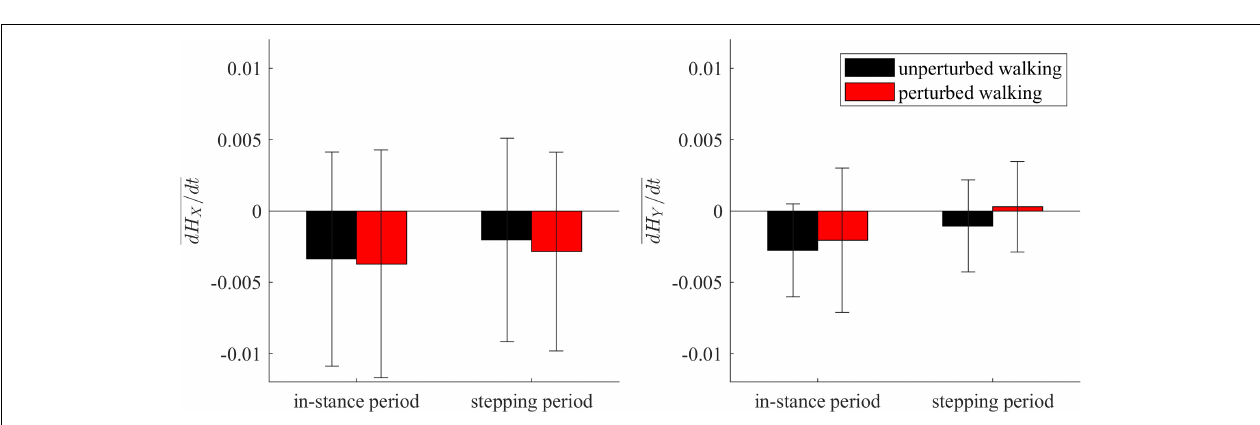
FIGURE 8 | Dimensionless group-average dH/dt (solid lines) responses after outward perturbations ( N = 12 for x direction and N = 11 for y direction). Dashed and dotted lines show individual components contributing to dH/dt as indicated in the legend. Black corresponds with the unperturbed experimental condition, red with perturbed experimental conditions. One gait cycle divided into the in-stance and stepping periods, normalized to its duration separately for each experimental condition, is shown following a perturbing push. To visualize normalization of both periods short discontinuity is introduced on abscise. The perturbation period is marked with the red bar. Periods where statistically significant changes were determined between both experimental conditions are indicated with piece-wise continuous black lines on top of each graph.